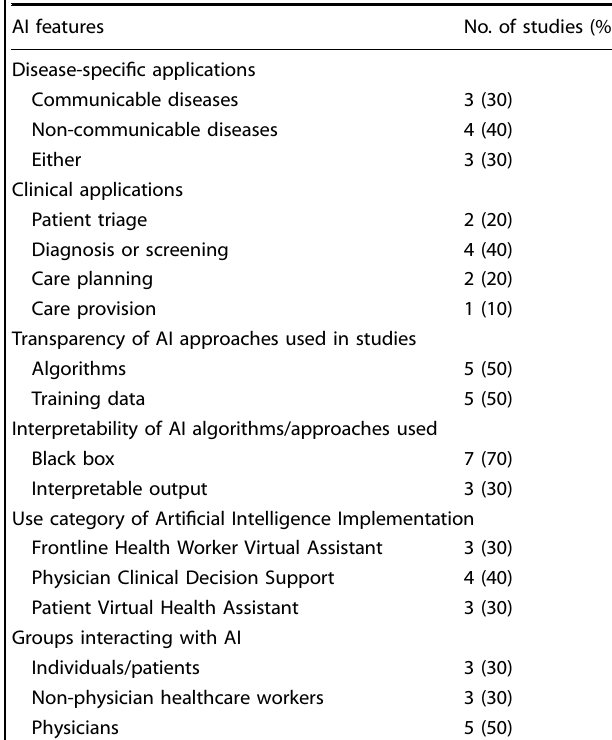
Table 2. Key characteristics of included studies. Table 3. Key features of implemented AI